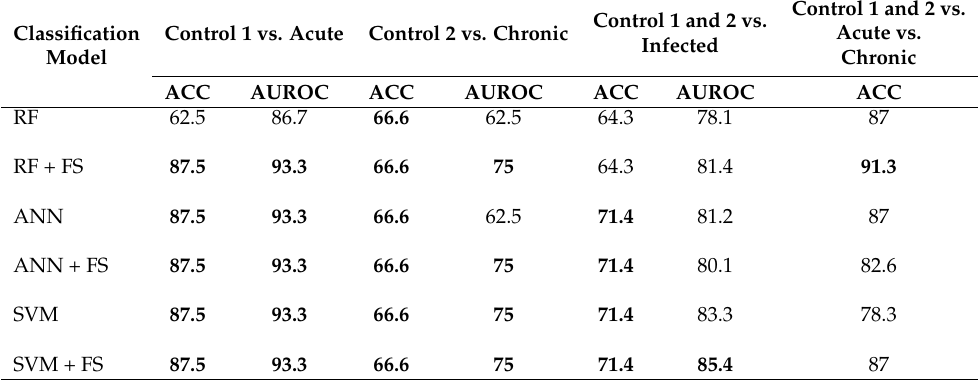
Table 4. Final test results with hold-out data. The best classification results are presented in bold, where all performances are shown as a percentage